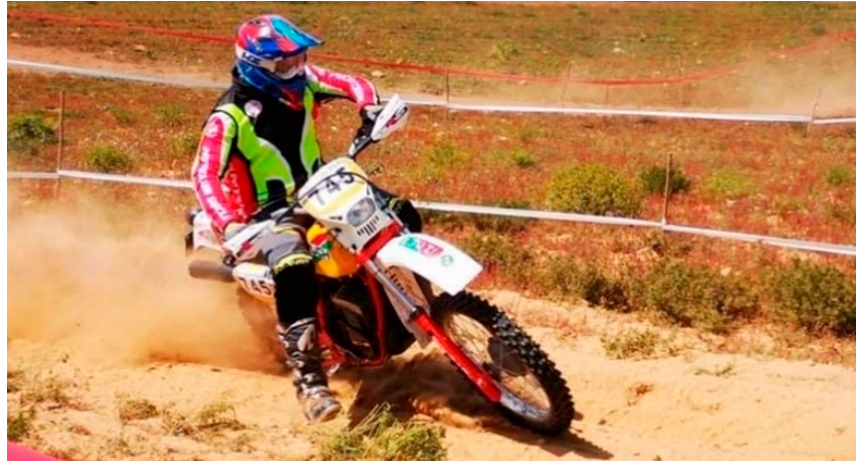
Figure 2. The forty ‐ five ‐ year ‐ old motorcyclist during a race. Figure 2. The forty-five-year-old motorcyclist during a